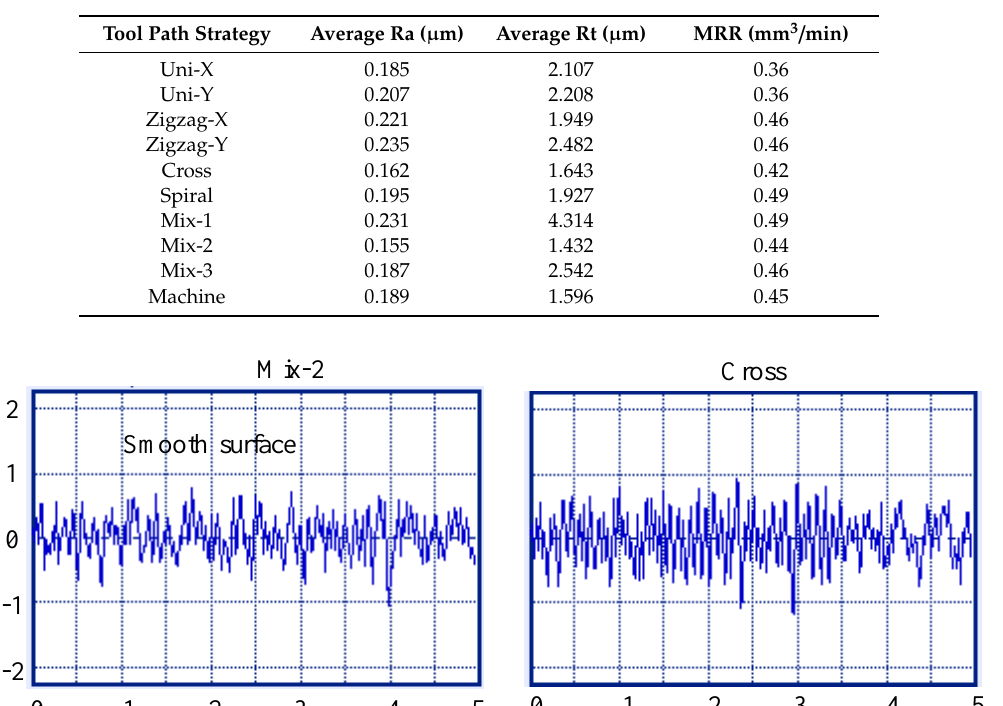
Table 5. Results of tool path strategies.